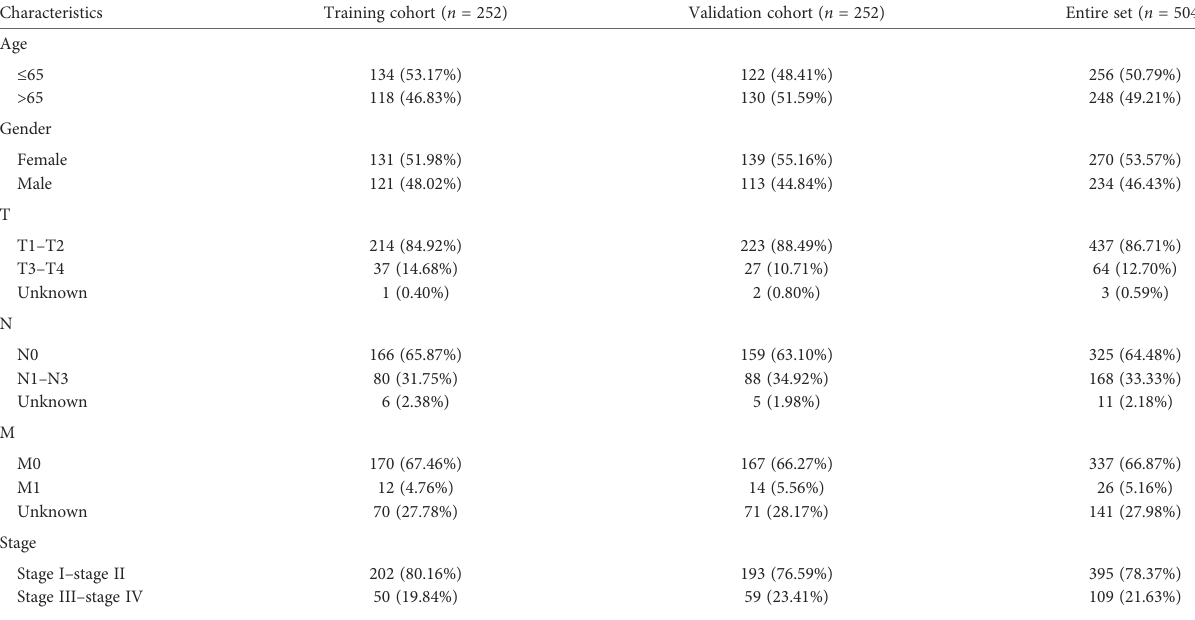
TABLE 2 The clinicopathologic characteristics of 504 lung adenocarcinoma patients in The Cancer Genome Atlas.